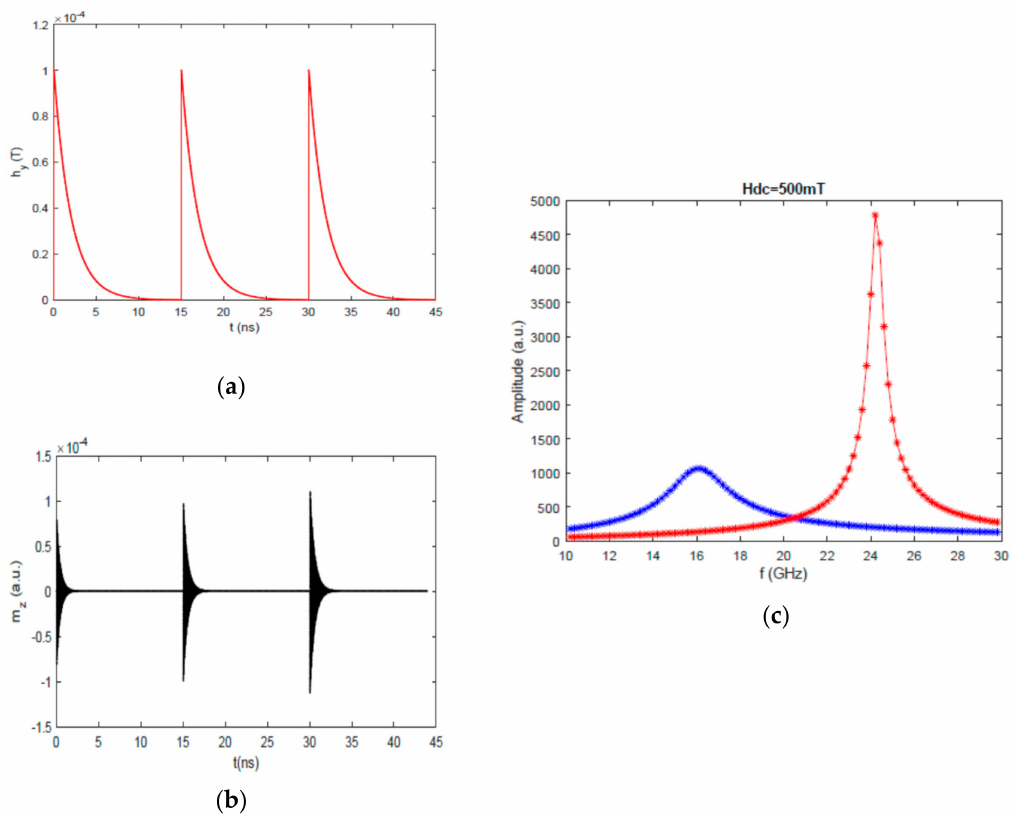
Figure 5. NdCo 5 -(2.5 nm-Al)-Py; ( a ) temporal evolution of h pulse applied to the hybrid structure; ( b ) out-of-plane, m z , dynamic Py response for H DC = 80, 60 and 50 mT (from left to right); ( c ) amplitude of the FT response of NdCo 5 (blue) and Permalloy (red) under 50